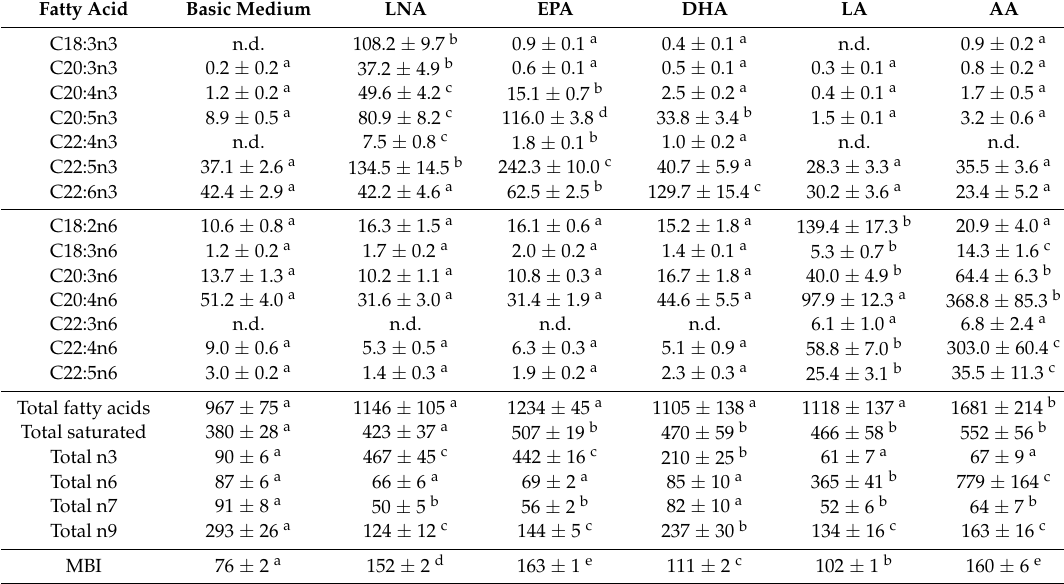
Table 1. Fatty acid patterns (nmol/L × 10 7 cells) and methylene bridge index (MBI) of TIME cultured for 144 h in basic medium as well as in medium supplemented with 15 µ mol/L alpha-linolenic acid (LNA, C18:3n3), eicosapentaenoic acid (EPA, C20:5n3), docosahexaenoic acid (DHA, C22:6n3), linoleic acid (LA, C18:2n6), and arachidonic acid (AA, C20:4n6), respectively, as determined by